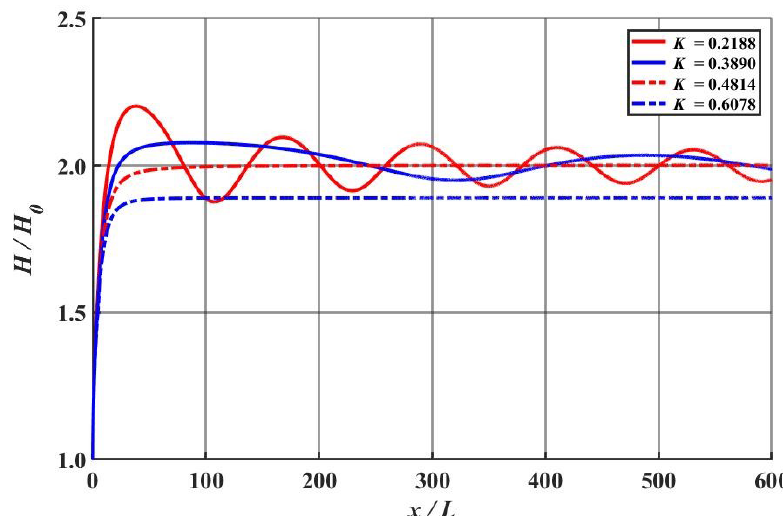
Figure 12. Comparison of calculated normalized wave heights along the wall for various nonlinear parameter values of K ( θ 0 = 10 ◦ ).